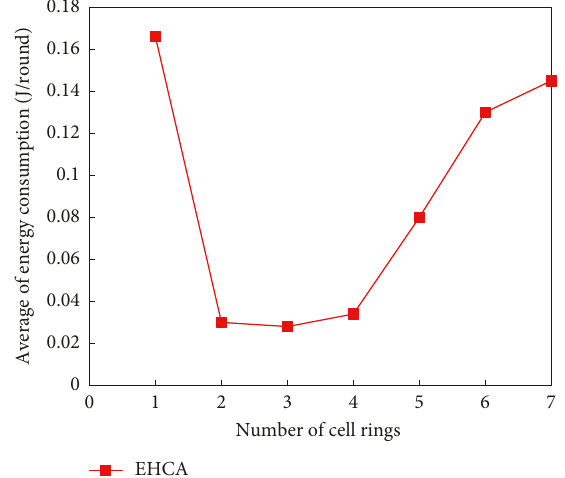
Figure 7: Average of energy consumption per round according to the number of cell